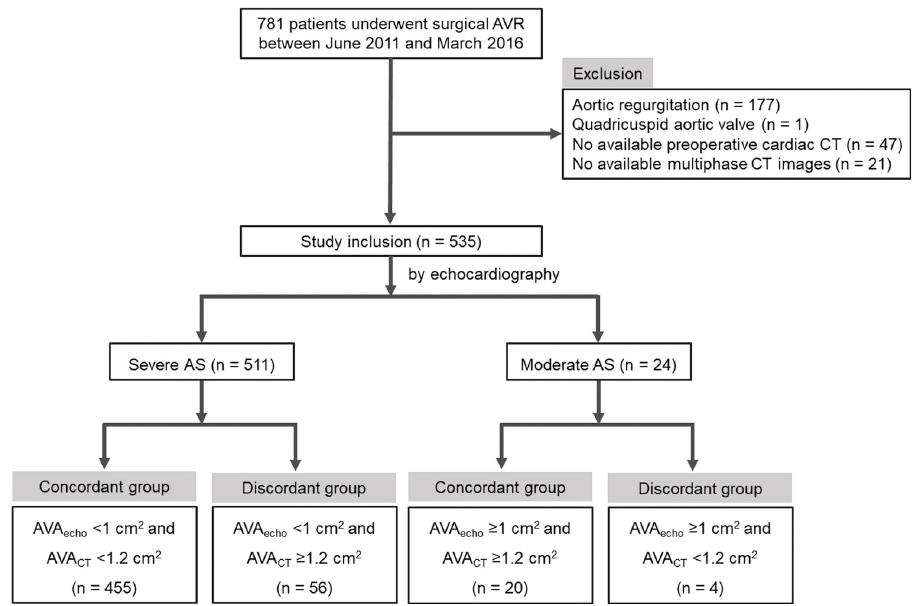
Fig 2. Flow chart of patient inclusion. AS, aortic stenosis; AVR, aortic valve replacement; AVA, aortic valve